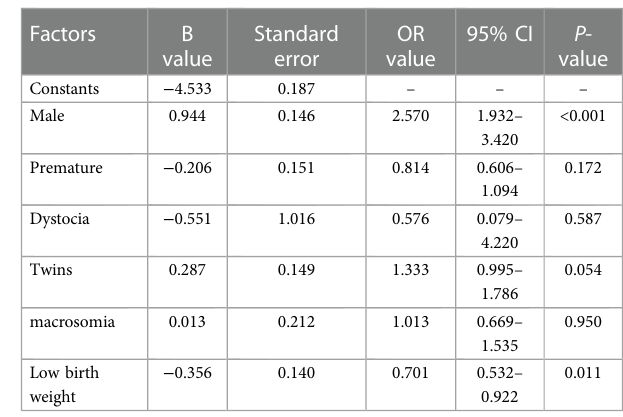
TABLE 5 Multivariate logistic analysis of risk factors for moderate to severe